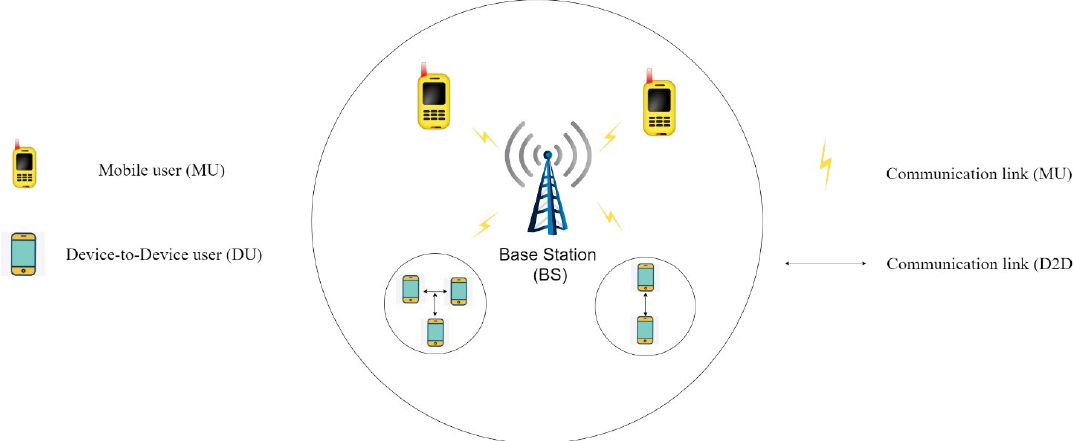
Figure 1. D2D-CRN Environment.